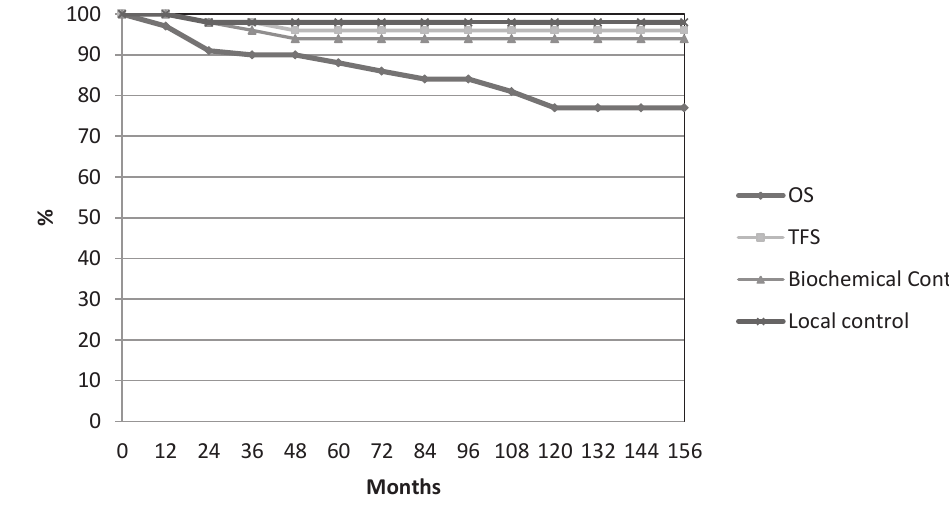
Figure 1. actuarial analysis of all 57 patients for overall survival, tumor-free survival and biochemical control and local